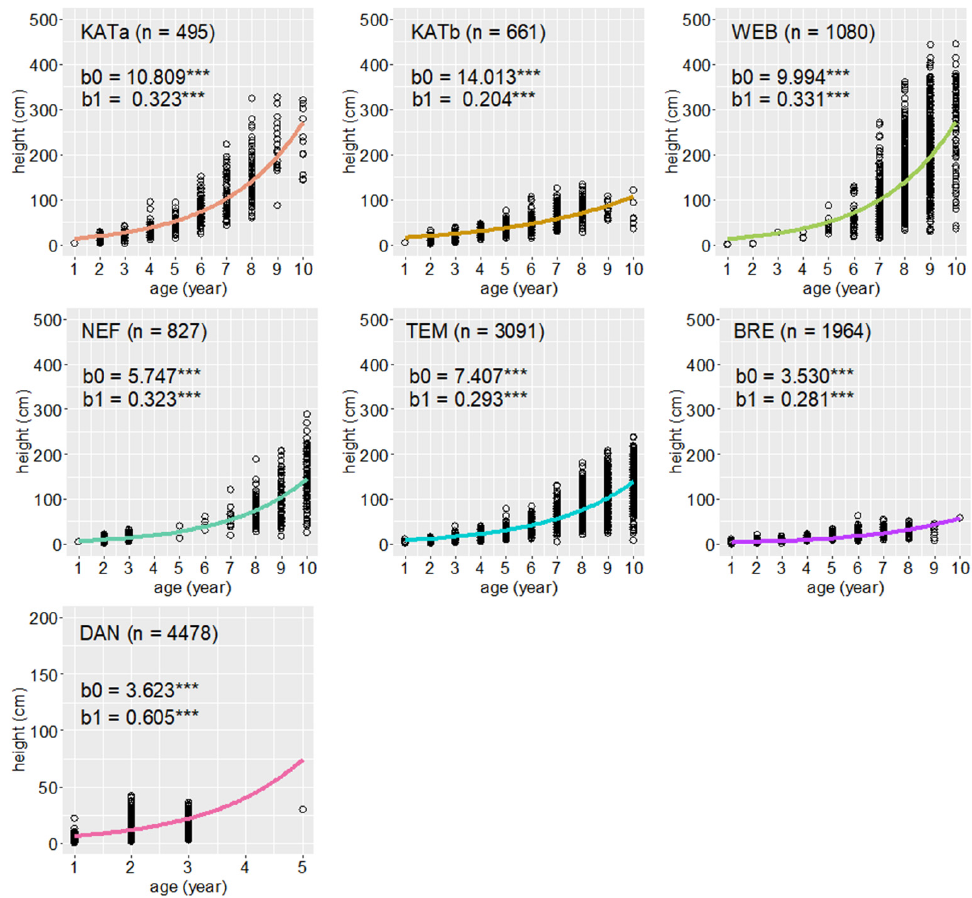
Figure 3. Age-dependent height growth functions for Scots pine up to an age of 10 years depicted separately for each site (non-linear regression model, nls model: height.cm ~ b0 ×-exp (b1 ×- age)). Note the different scale for the site DAN.